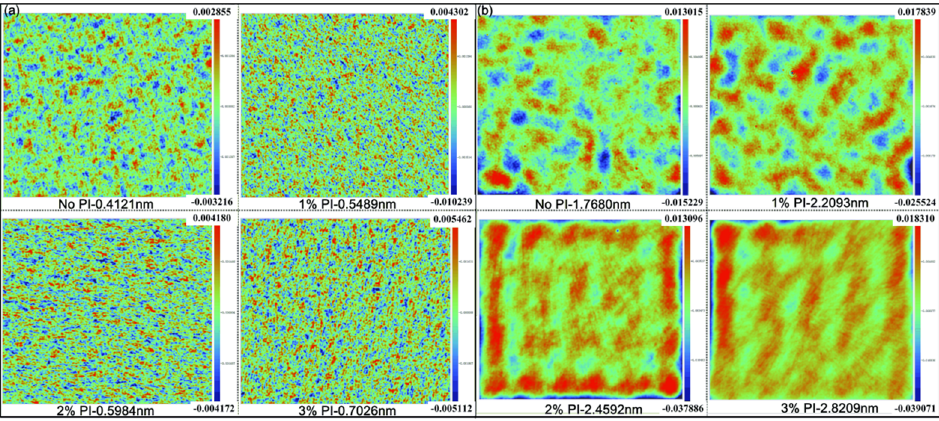
Figure 4. 1 ω and 2 ω laser-induced damage threshold (LIDT) of HRI coatings with different PI concentrations.